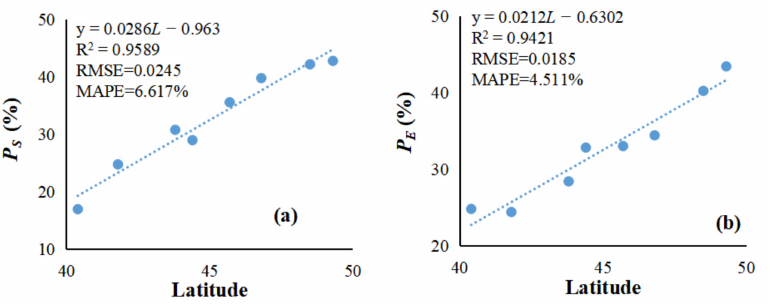
Figure 4. The variation of the extraction threshold corresponding to the observed phenology at each station with latitude ( a ) is the SOS and ( b ) is the